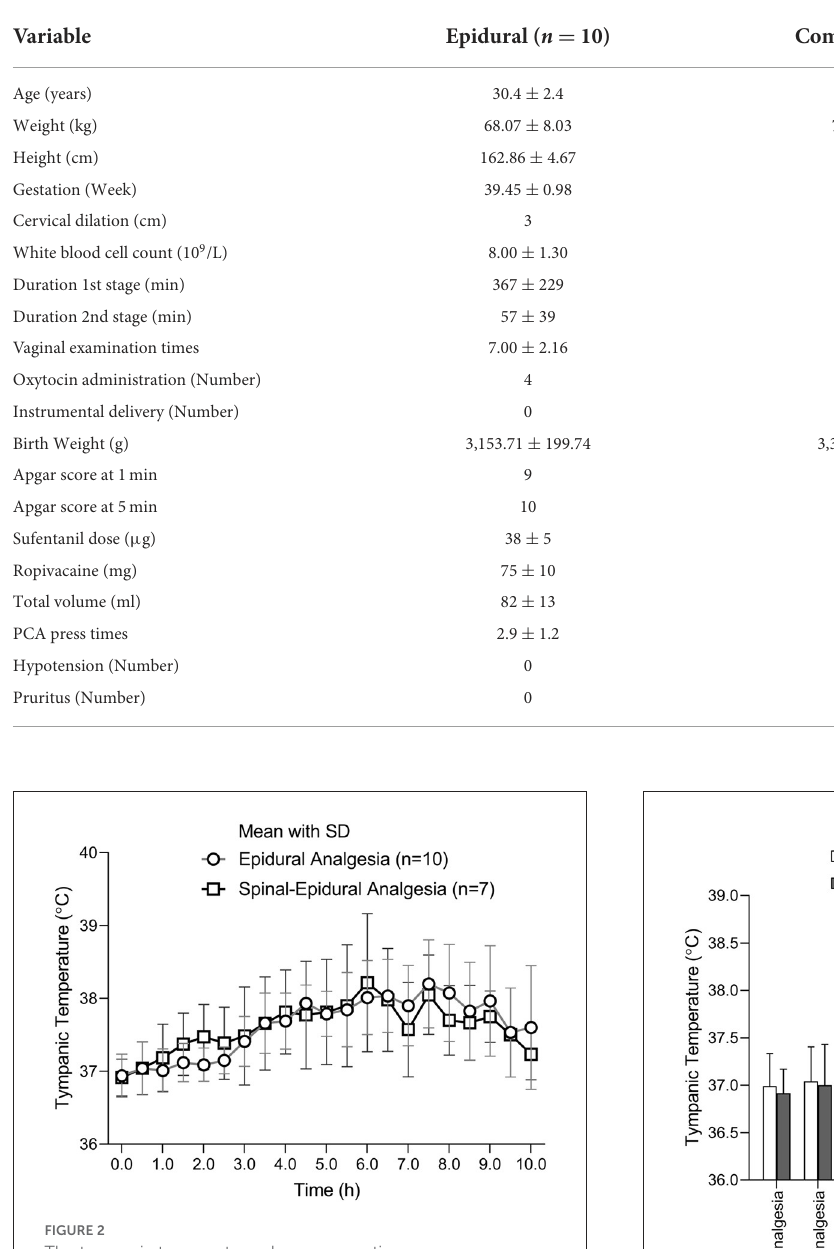
TABLE 2 Characteristics of the parturients with fever at admission and the delivery outcomes after vaginal delivery.